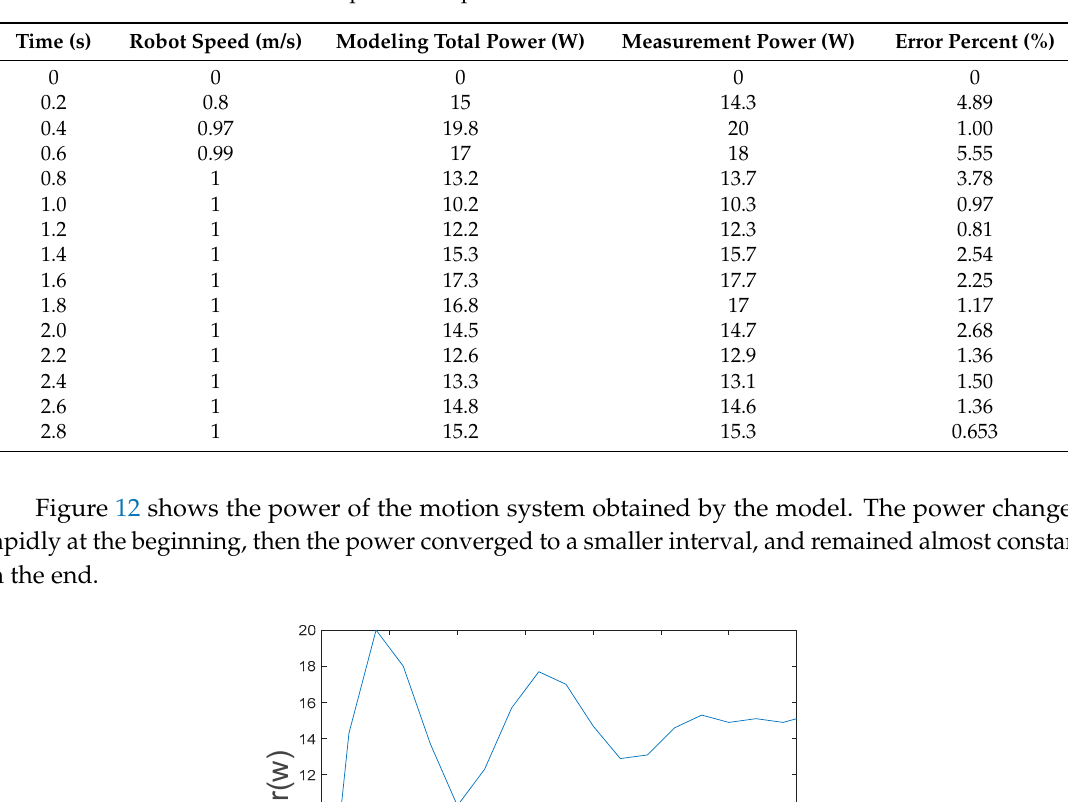
Table 3. Motion power comparison between model and measurement.